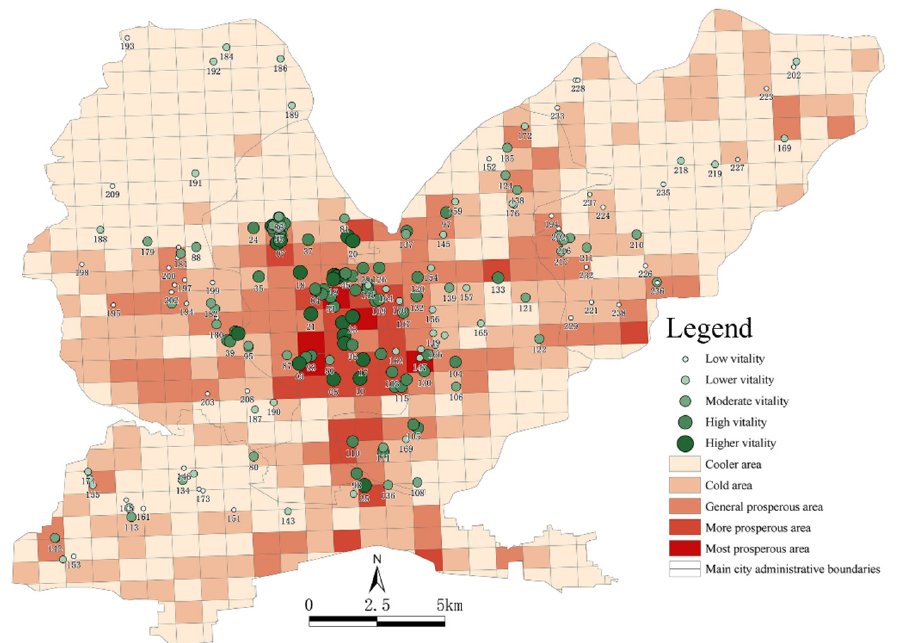
Figure 11. The vitality of parks and squares in the four districts of the main urban area in Jiaozuo.